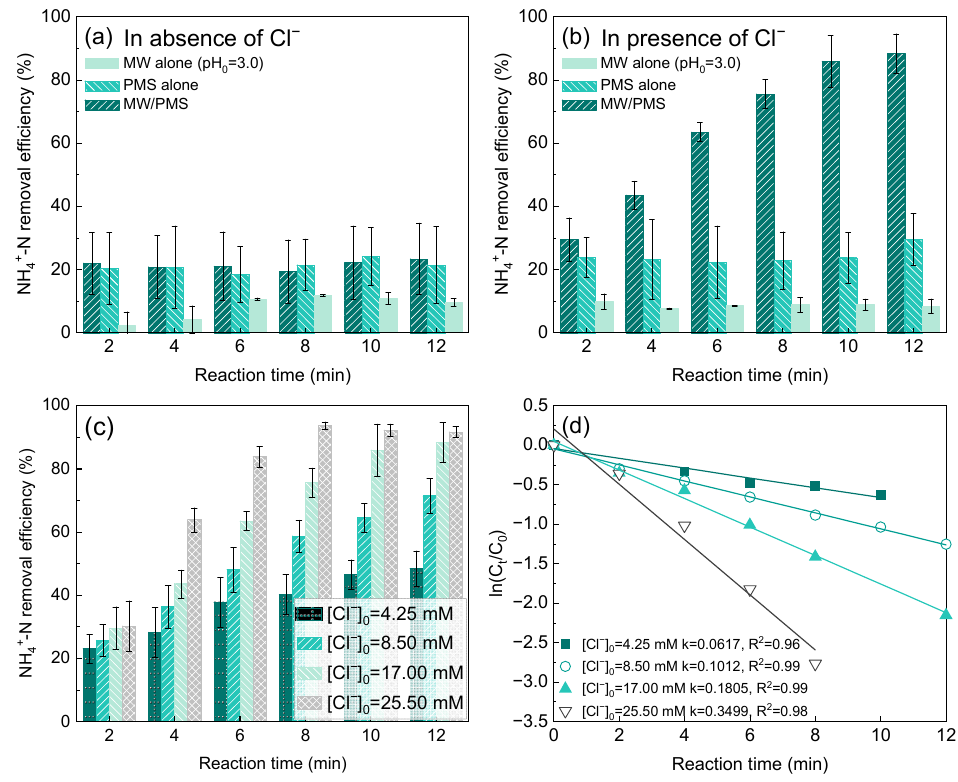
Figure 1. Effects of Cl − on NH 4+ -N removal. Removal of NH 4+ -N by MW alone, PMS alone, and MW/PMS in ( a ) the presence and ( b ) absence of Cl − , and the effects of Cl − concentration on ( c ) NH 4+ -N removal efficiency and ( d ) rate by the MW/PMS system. Reaction conditions: MW power = 160 W, [PMS] 0 = 10 mM, [Cl − ] 0 = 17.00 mM, and [NH 4+ -N] 0 = 60